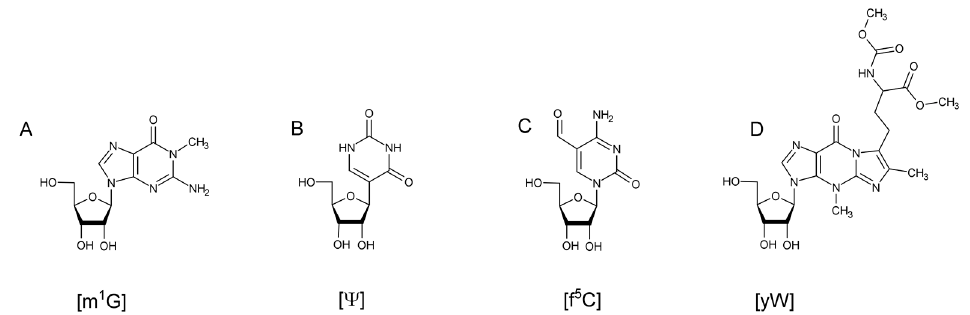
Figure 1. Examples of different types of RNA modifications. ( A ) 1-methylguanosine (m 1 G) methylation; ( B ) pseudouridine ( ψ ) isomerization; ( C ) 5-formylcytidine (f 5 C) formylation; and ( D ) wybutosine (yW) a hypermodification as the result of multiple enzymatic reactions.